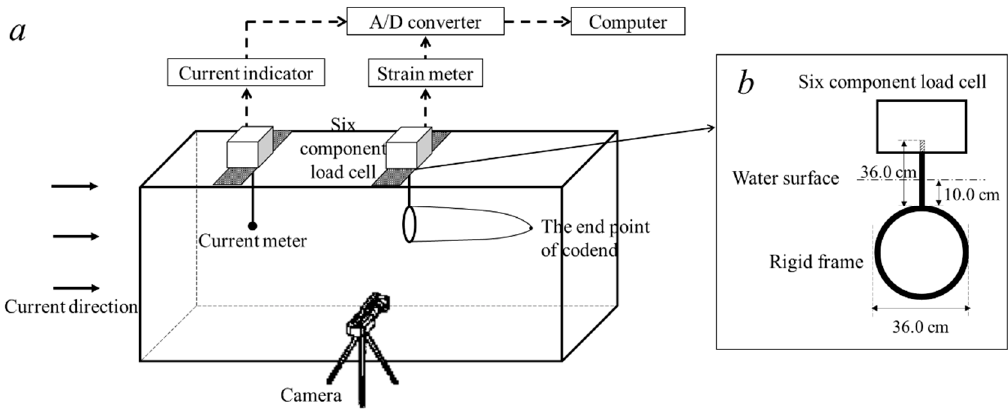
Figure 2. The setup of flume tank experiment ( a ): schematic diagram of experimental set up and apparatus for codend testing; ( b ): schematic diagram of rigid frame).